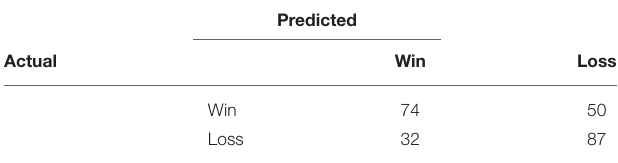
TABLE 7 | Classification accuracy—decision